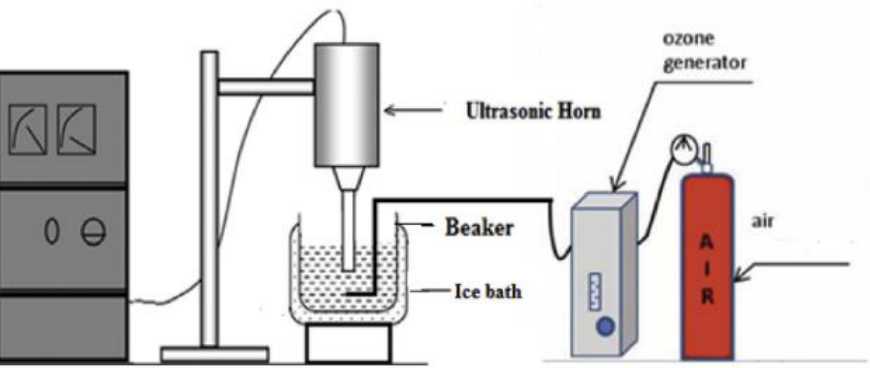
Figure 8. Schematic representation of experimental setup for degradation with US/ozone combina- tion. Reprinted with permission from [45].